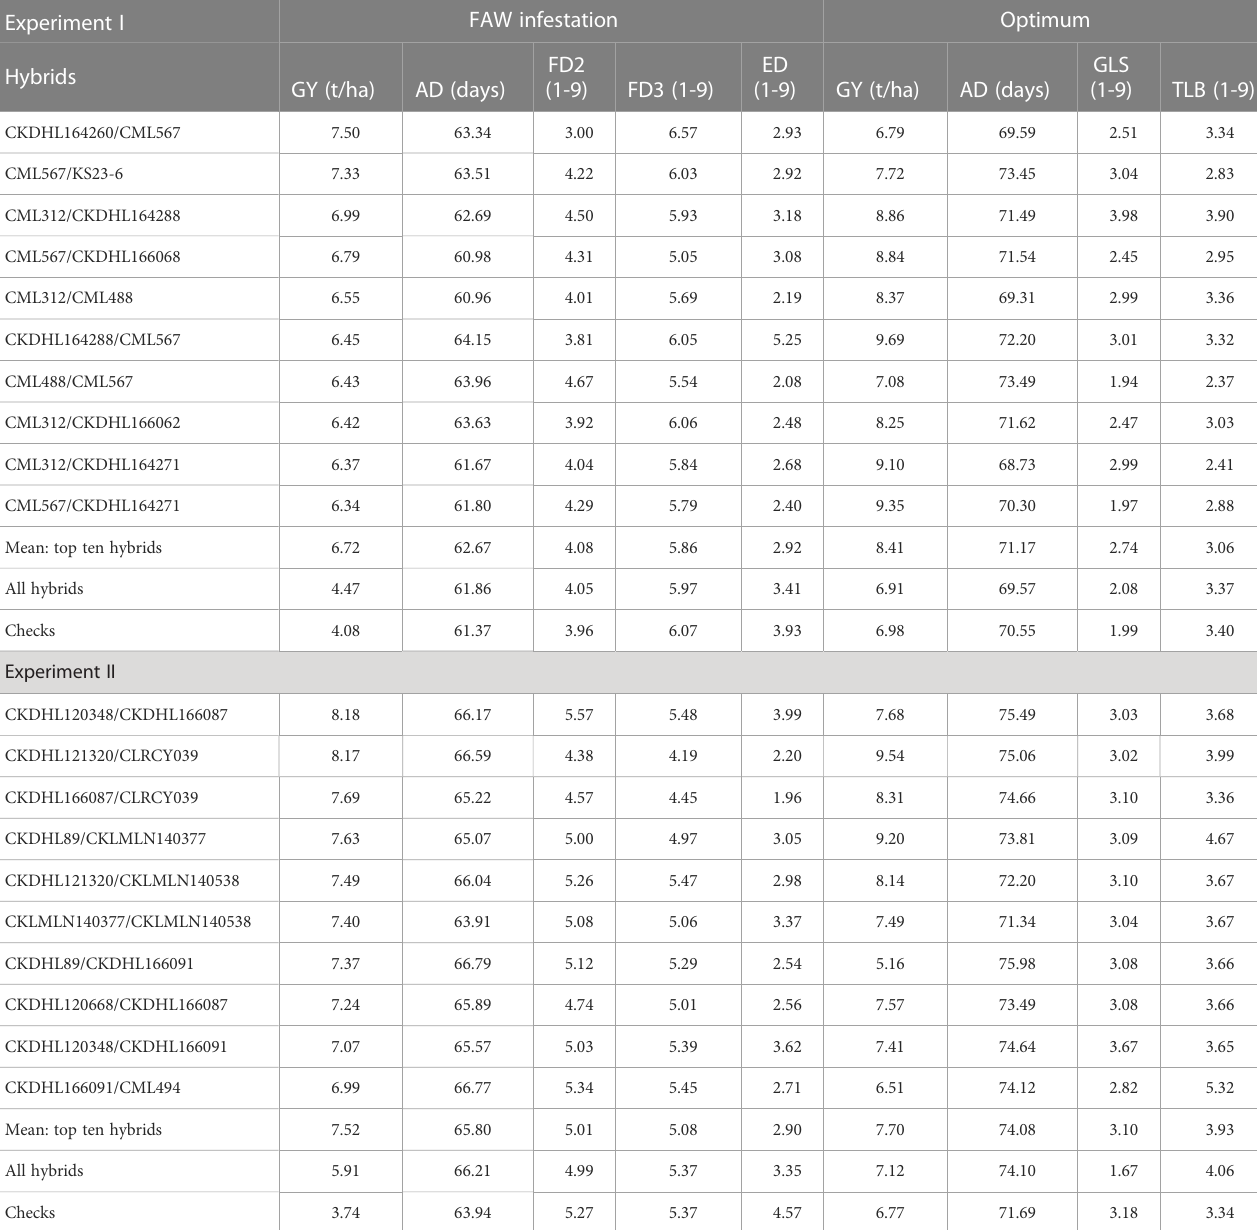
TABLE 4 Mean performance of best 10 F 1 experimental hybrids for grain yield and other agronomic traits under FAW infestation and optimum conditions in two diallel experiments. Experiment I FAW infestation